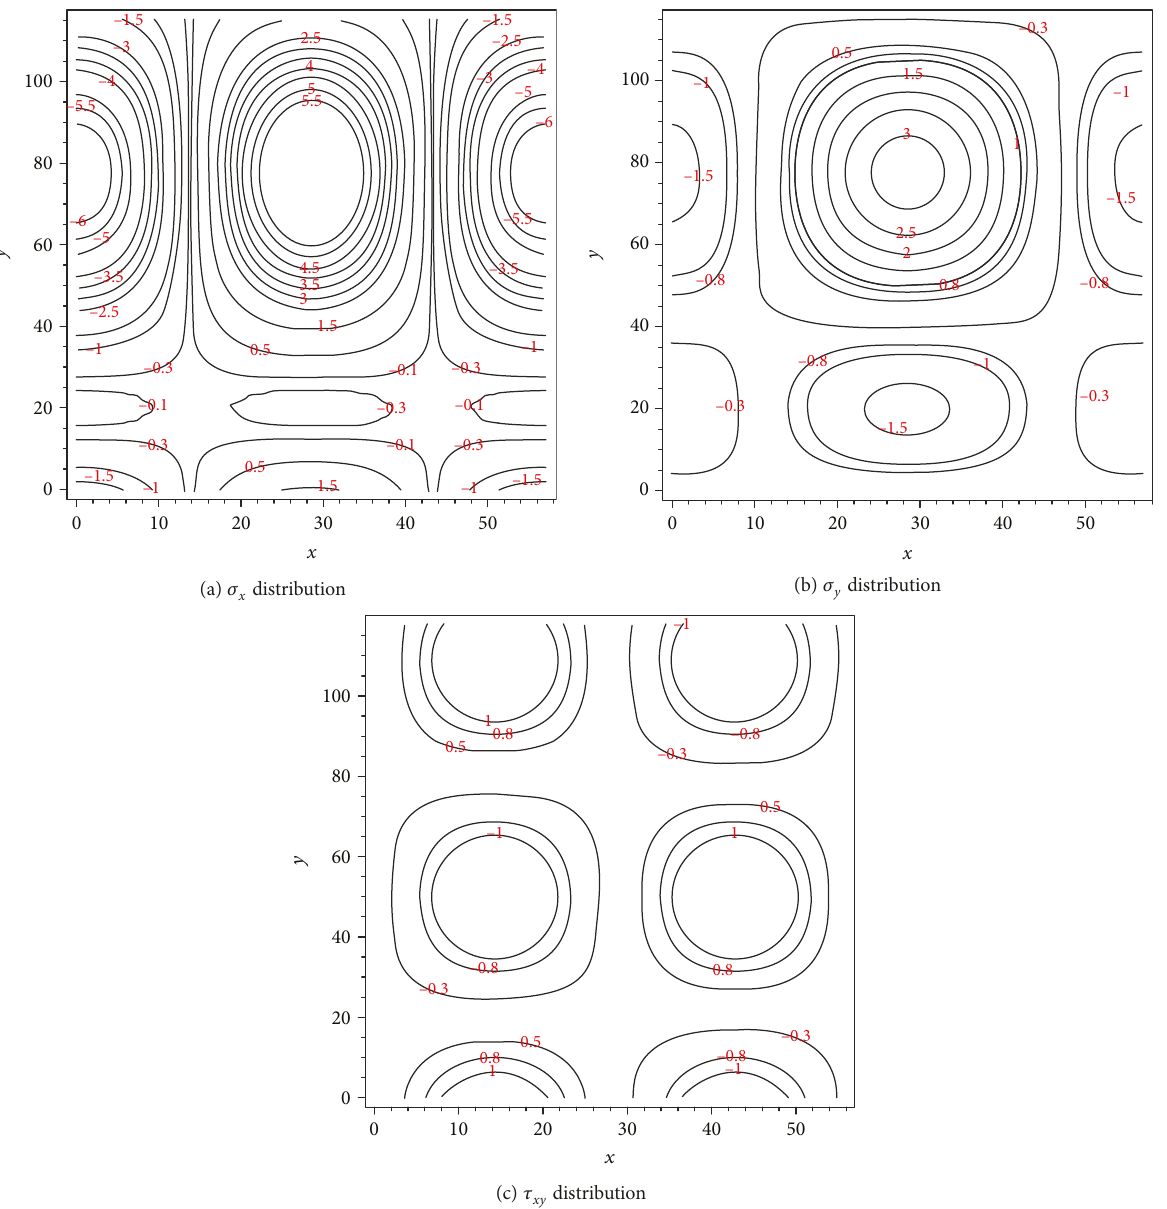
Figure 7: Stress distribution in the roof in di ff erent